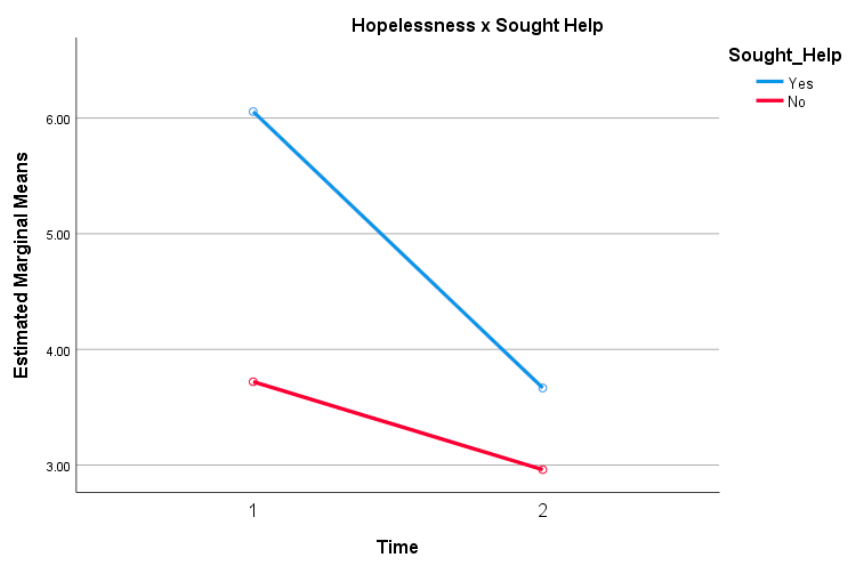
Figure 1. Observed interaction effect of hopelessness and previous help-seeking behavior. Sense of Presence. Table 3. Pre-post and change scores for interaction effect of Employment × Hopelessness (N = 79).